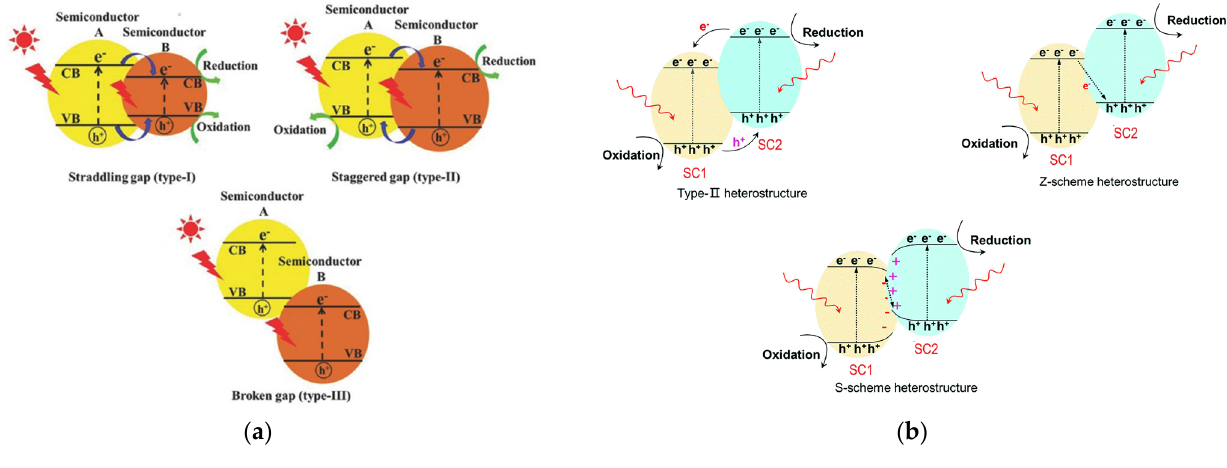
Figure 6. ( a ) Three types of conventional heterojunction photocatalysts. Reproduced from ref. [78] with permission from John Wiley and Sons. Copyright 2017 John Wiley and Sons. ( b ) Schematic diagram of the charge transfer in type-II, Z-scheme, and S-scheme heterojunctions. Adapted from ref. [81] with permission from The Royal Society of Chemistry. Copyright 2021 The Royal Society of Chemistry.